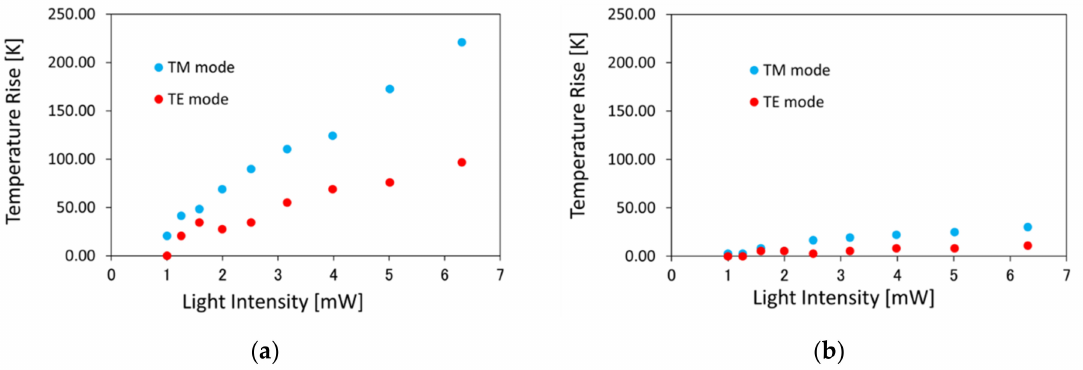
Figure 6. Estimated local temperature rise for TM and TE mode light with the Si waveguides having the waveguide width w = ( a ) 400 nm, and ( b ) 1000